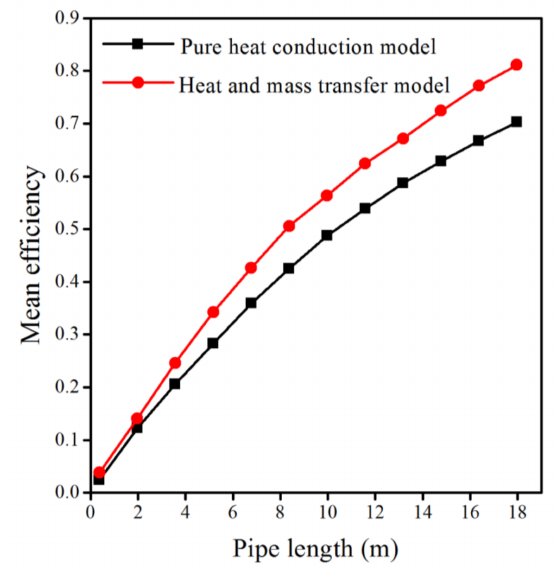
Figure 10. Influence of the pipe length on the daily mean